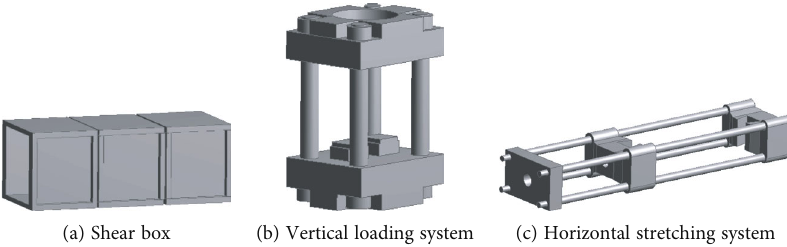
Figure 6: Main structure model of a test